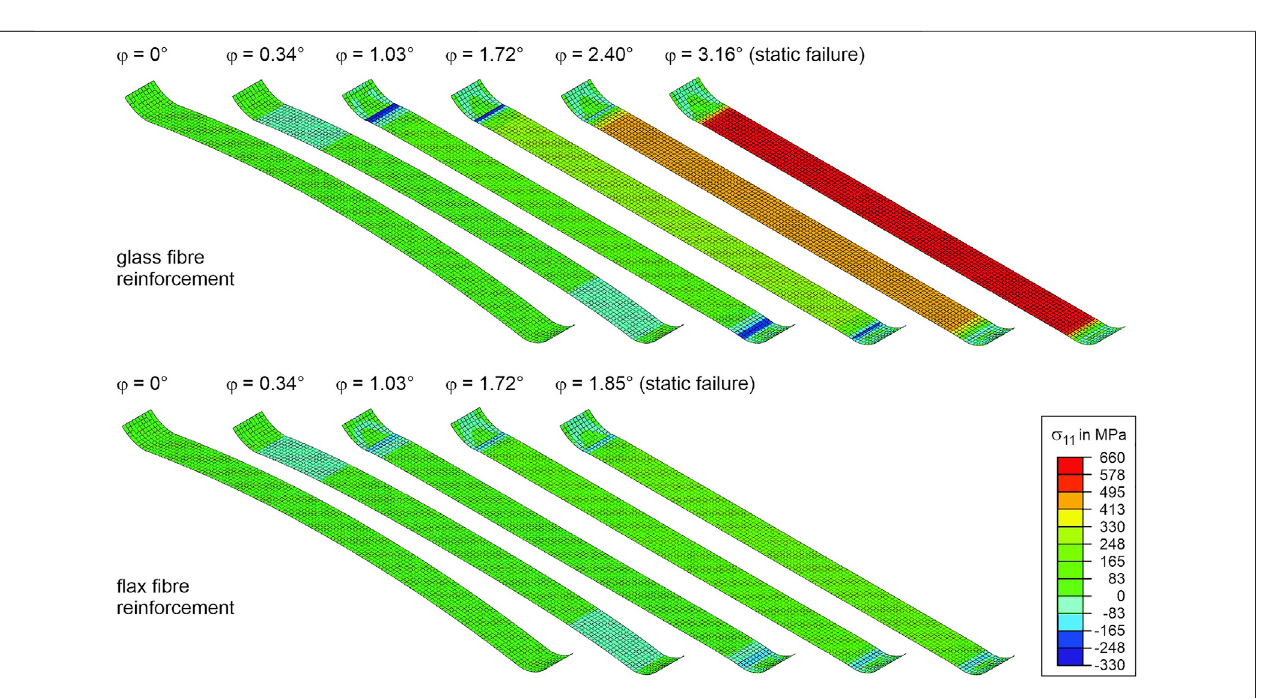
FIGURE 13 | Finite element results of the axle